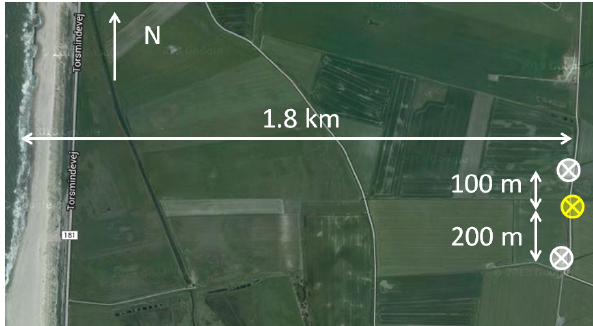
Figure 2. A close-up of the Høvsøre field site (yellow cross) with surrounding wind power turbines (white crosses). The sparsely traf- ficked local road (in north–south direction) is in the middle of the picture and the coastal road (Torsmindevej) is next to the coastline near the left edge of the